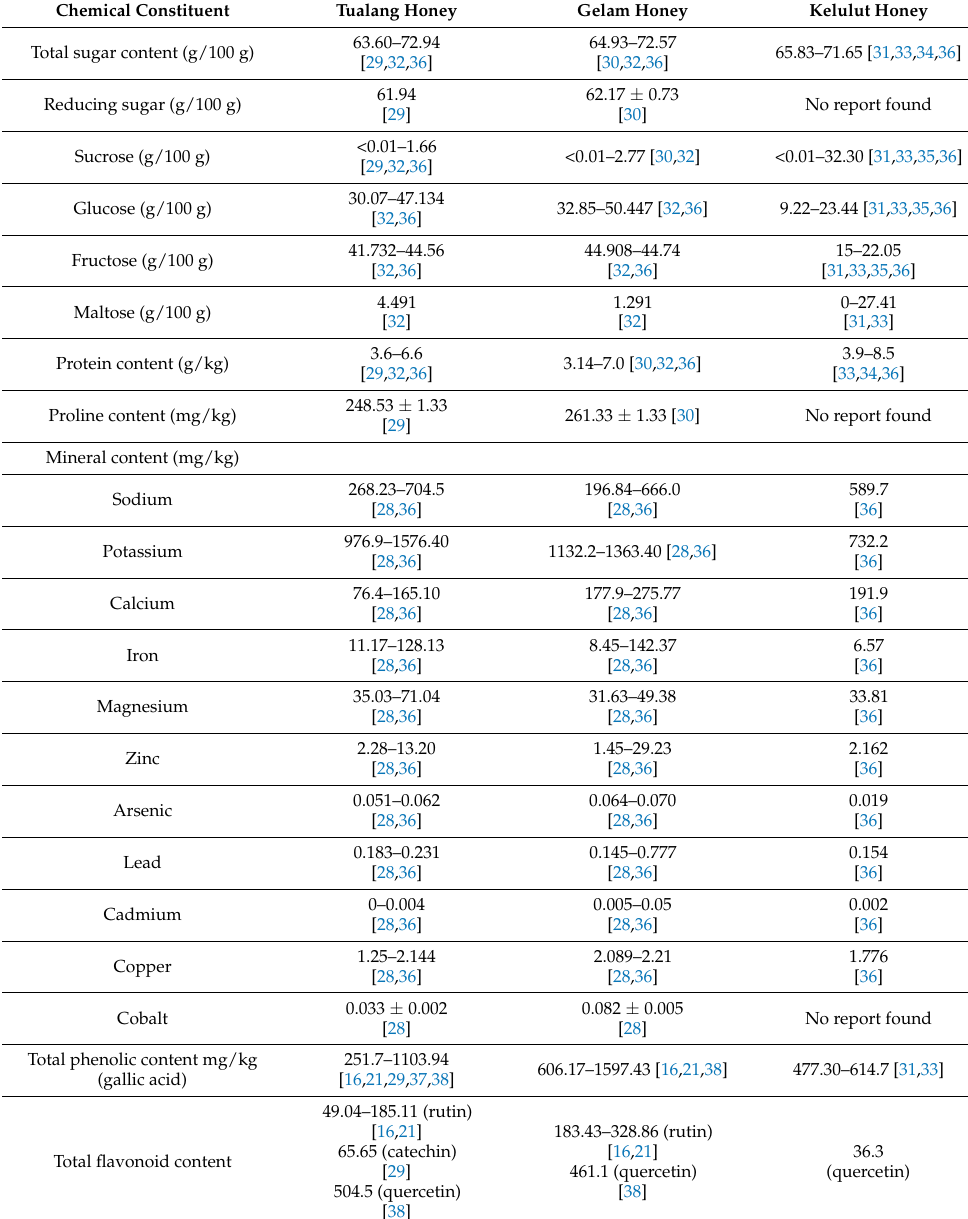
Table 2. Chemical constituents of Tualang, Gelam and Kelulut